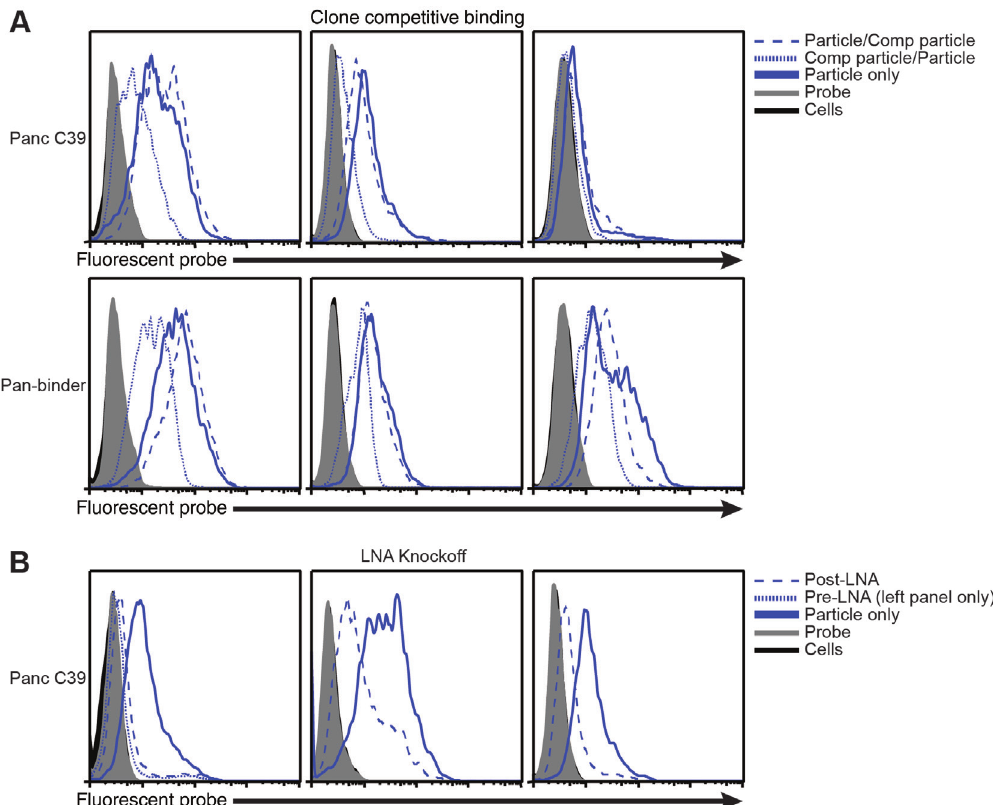
Figure 4 DeNAno competitive binding. (A) Panc-02-specific C39 clone was tested against a pan-binding particle. Top panel: labeled C39 particles were incubated with Panc-02 cells only (solid line), labeled C39 followed by unlabeled pan-binder (dashed line; in all graphs, the unlabeled particle in the staining is the “comp particle” on the graph), or unlabeled pan-binder followed by labeled C39 (dotted line). Bottom panel: labeled pan-binder particles were incubated with Panc-02 cells only (solid line), labeled pan-binder followed by unlabeled C39 (dashed line), or unlabeled C39 followed by labeled pan-binder (dotted line). Graphs are three representative experiments. (B) Panc-02 cell line was stained with C39 (solid line), followed by incubation with locked nucleic acid (LNA) oligo complementary to the sequence motif (dashed line). As a control, particles were pre-incubated with the LNA (left panel only). Graphs are three representative